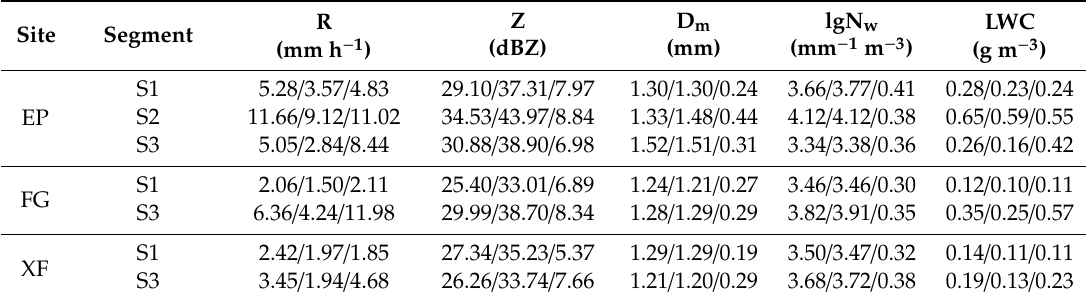
Figure 5. Temporal evolution of the number concentration ND (mm –1 m –3 , shown by lgND), rain rate R (mm h –1 ), radar reflectivity factor Z (dBZ), mass-weighted mean diameter D m (mm), and normalized number concentration N w (mm –1 m –3 , shown by the lgN w ) at the ( a – c ) EP, ( d – f ) FG, and ( g – i ) XF sites. Table 2. Microphysical characteristics of the raindrop size distributions of the three segments of Typhoon Mangkhut at the three sites. The 1st / 2nd / 3rd values are the means, medians, and standard deviations for specific periods, respectively.